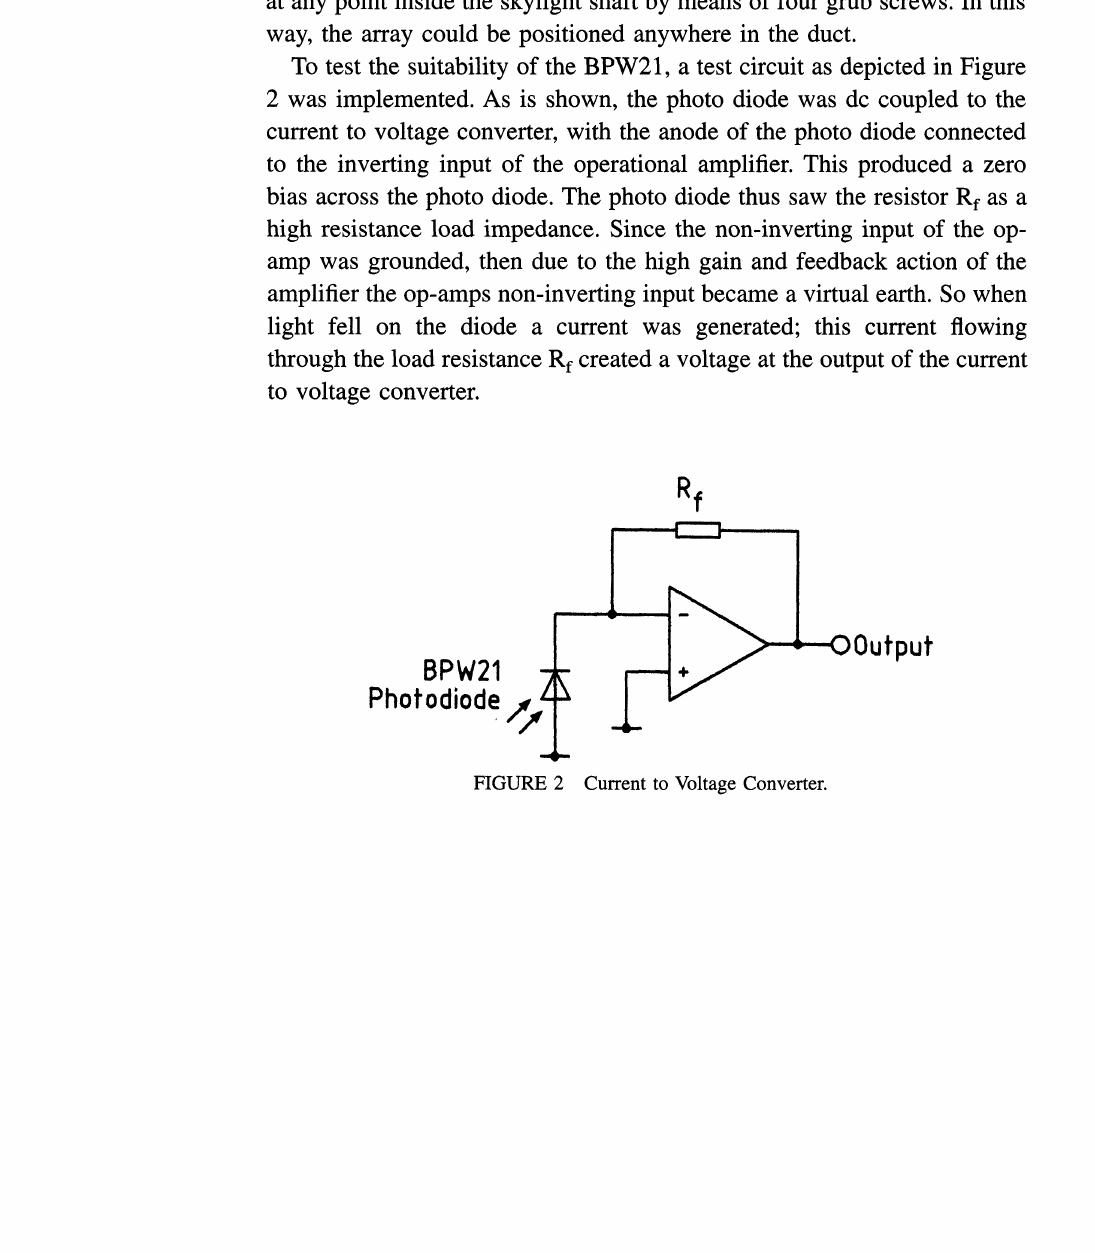
FIGURE 2 Current to Voltage